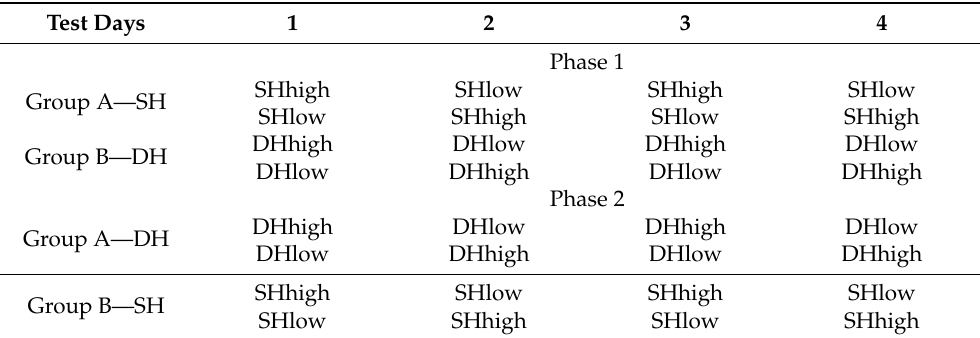
Table 1. Organisation of treatment groups by phase and day after randomly assigning horses (n = 6) to either Group A or B (SH = Single layered haynet; DH = Double layered haynet; low & high refers to hanging height). 1